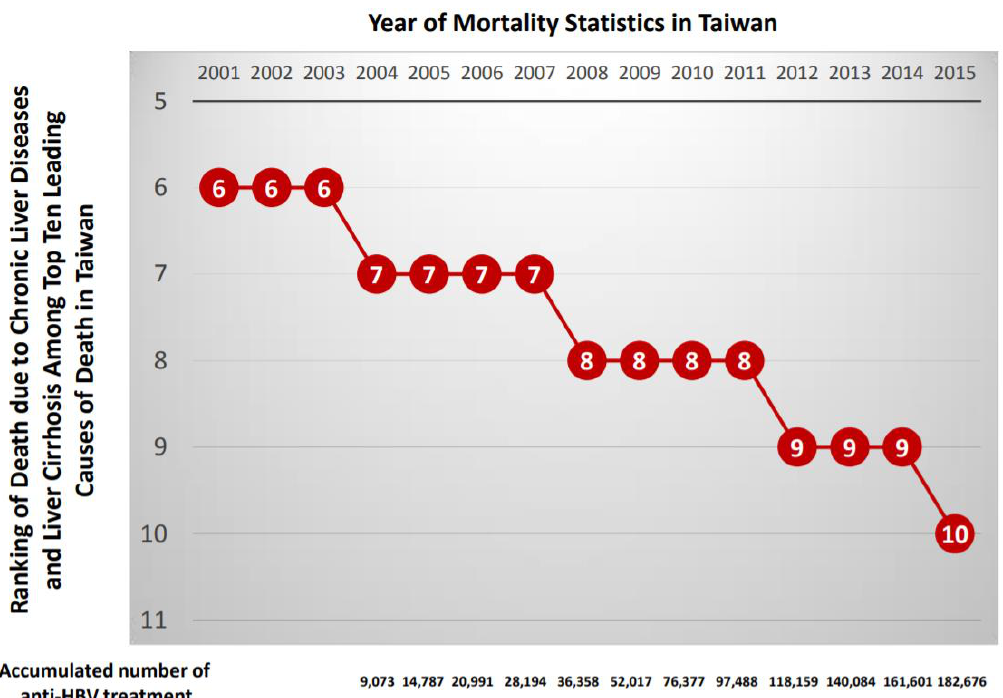
Figure 2. Ranking of deaths due to chronic liver diseases and liver cirrhosis among the top ten leading causes of death in Taiwan (from 2001 to 2015); cumulative number of patients receiving reimbursed anti-hepatitis B virus (HBV) treatment (from 2004 to 2015) is shown at the bottom (national reimbursement program for the treatment of chronic viral hepatitis launched in 2003; data released by the Ministry of Health and Welfare, Taiwan).